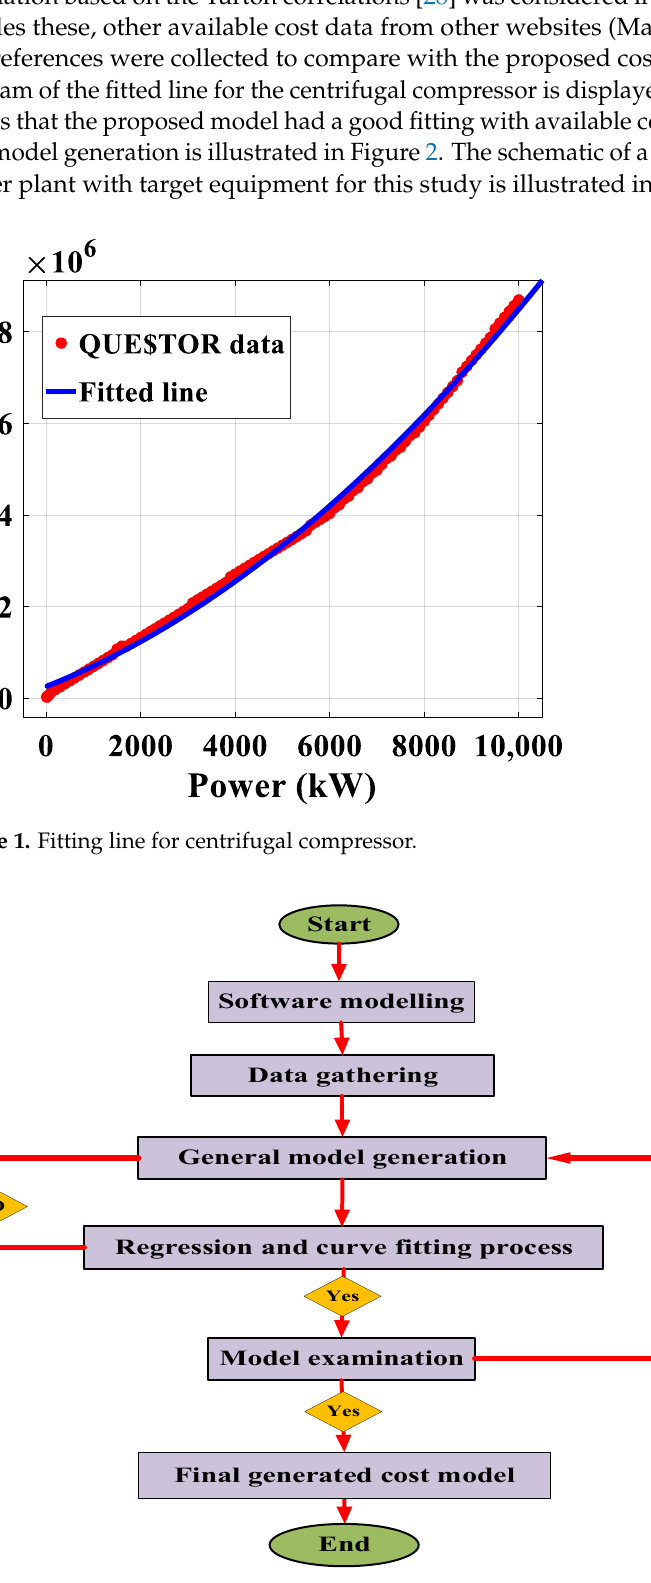
Figure 3. Scope of cost model for conventional geothermal power plant [50]. 3. Results and Discussion This research sought to generate equipment cost correlations according to the QUE$TOR modeling and cost database. The reference database was related to the first quarter of 2020, and the extracted correlations were applicable to studies dedicated to fu- ture power plant economic assessments. They could help researchers and stakeholders